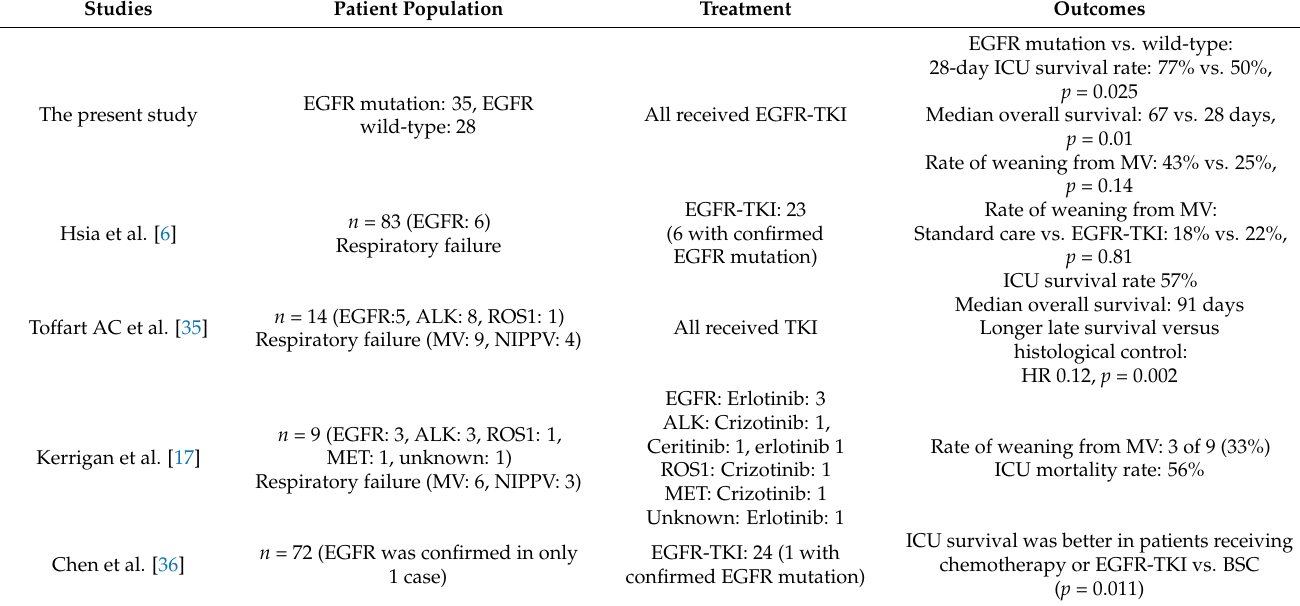
Table 5. Summary of prior studies of EGFR-TKI use for lung cancer patients admitted to intensive care units. Studies Patient Population Treatment